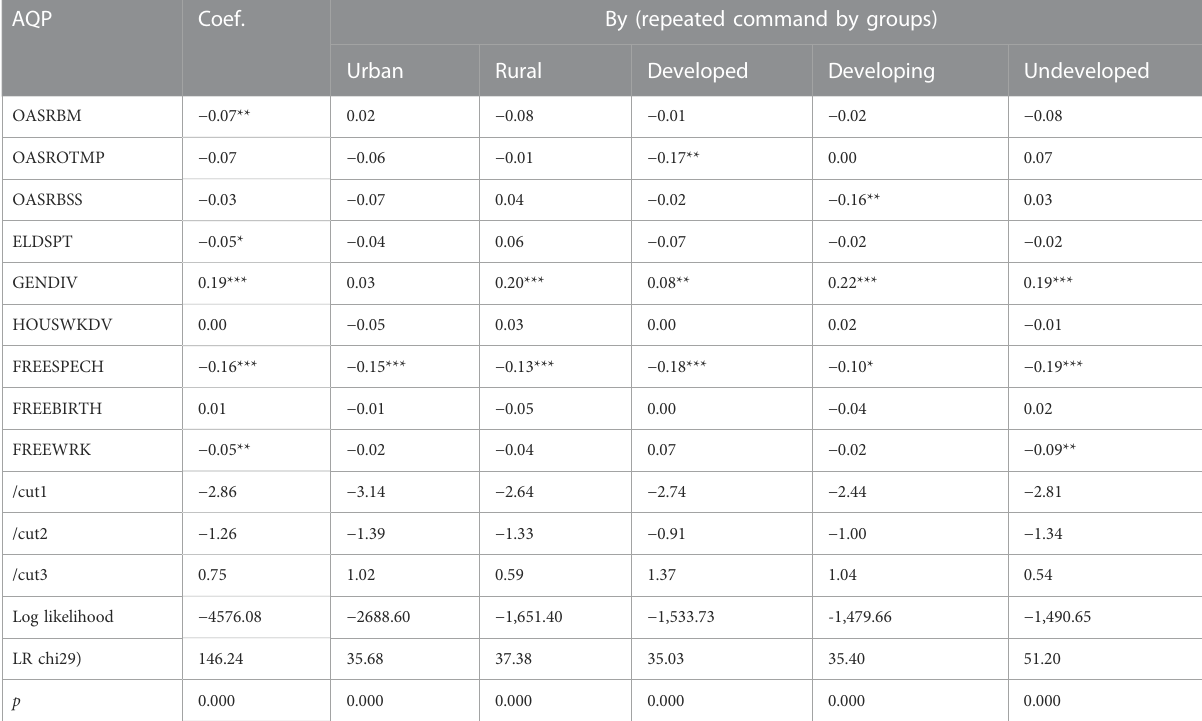
TABLE 6 Coef. of AQP and individualism. AQP